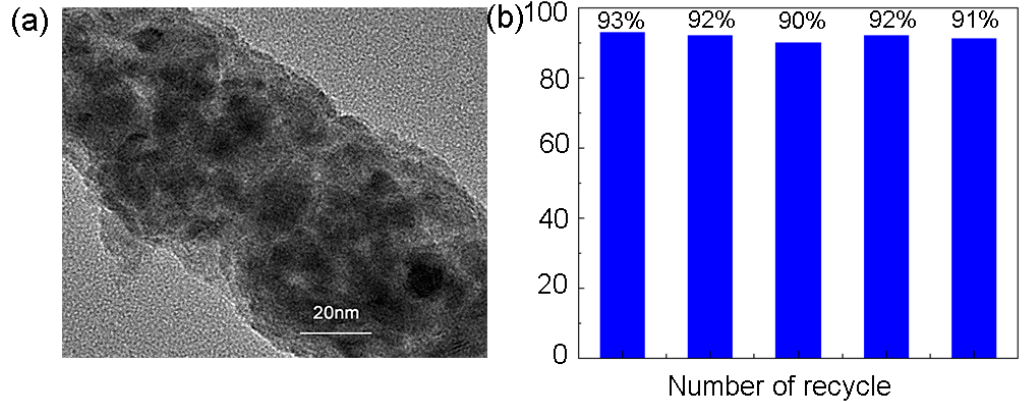
Figure 10. ( a ) Transmission Electron Microscopy (TEM) images of Cu-loaded modified chitosan microspheres (CSM@ Cu 0 ) after recycling five times. ( b ) Stability of CSM@ Cu 0 over the boron addition reaction.